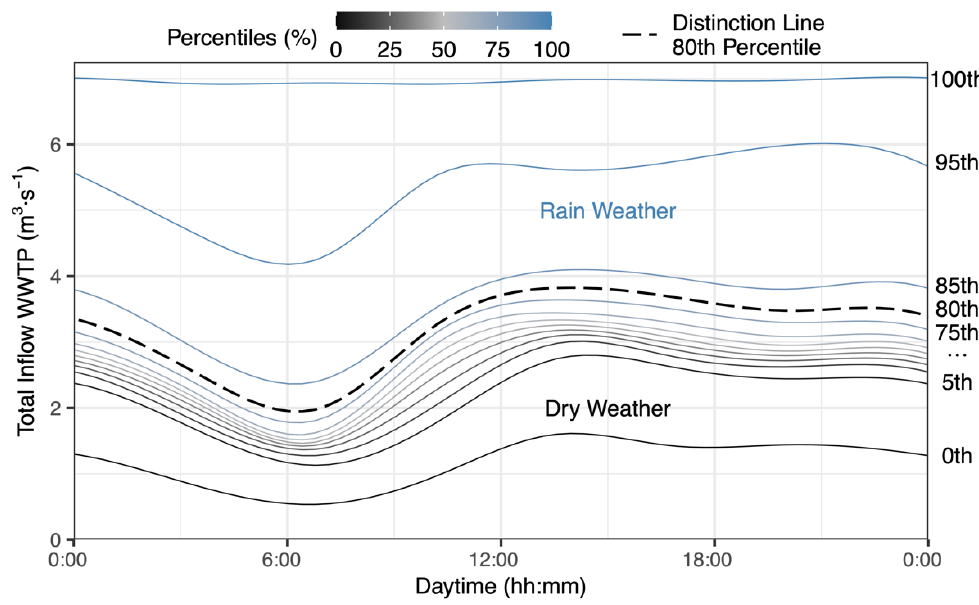
Figure 1. Assigning weather category on the basis of diurnal variations of total wastewater